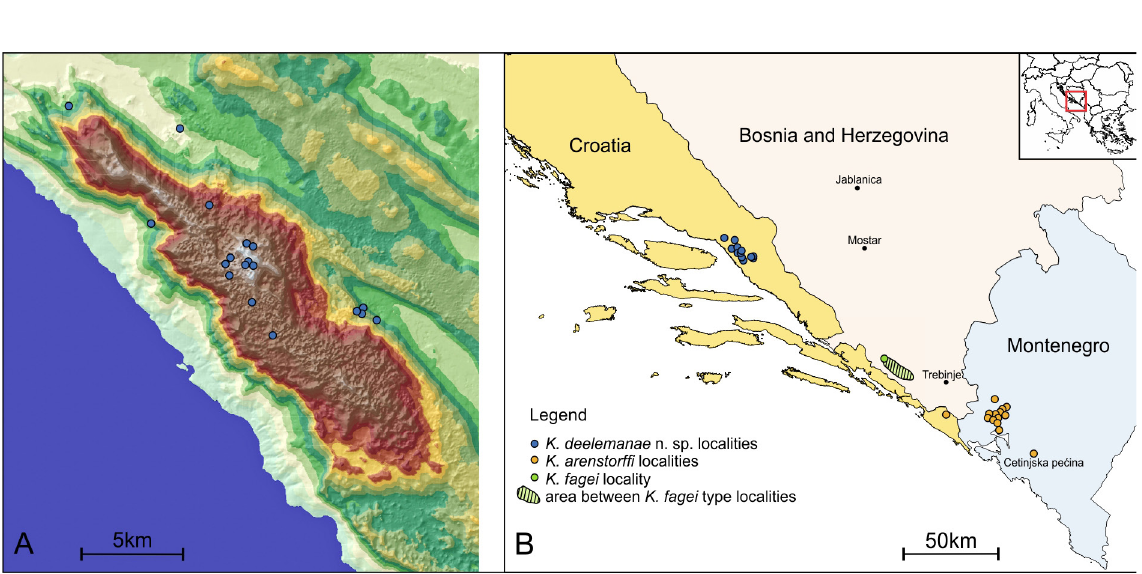
Fig 6. Distribution maps. A. Map of Biokovo Mt with distribution of Kryptonesticus deelemanae gen. et sp. nov. B . Map with distributions of K. deelemanae gen. et sp. nov., K. fagei